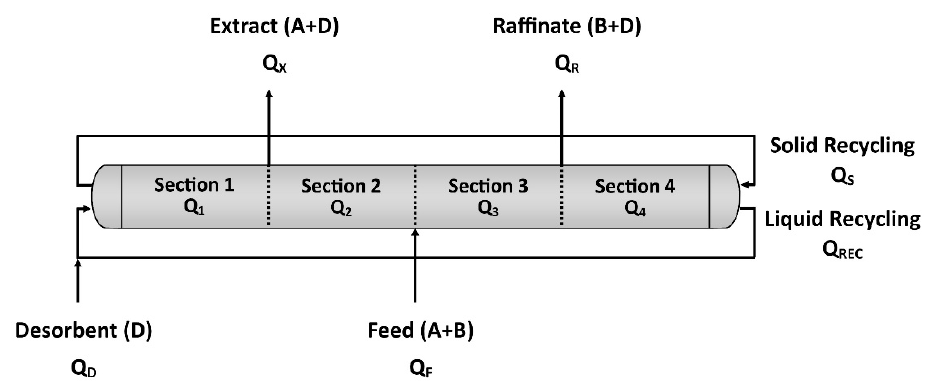
Figure 2. Schematic representation of a true moving bed.